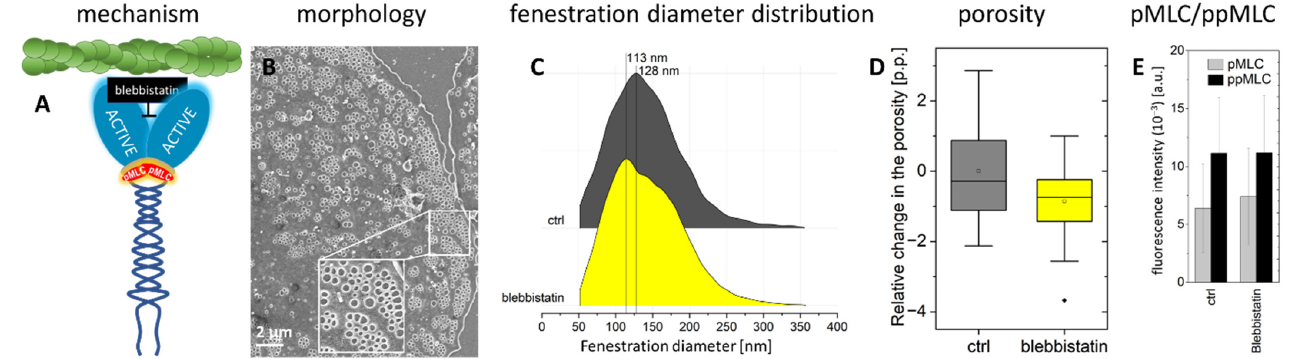
Figure 5. The effect of myosin heavy chain inhibition by 20 µM blebbistatin. ( A ) Schematic presentation of the blebbistatin effect—myosin cannot exert a force on actin, as the myosin motor domain is blocked. The use of blebbistatin uncouples the dependence of pMLC activation on actomyosin contraction. ( B ) Representative SEM image of LSEC treated with 20 µM blebbistatin. ( C ) Fenestration diameter distribution (number of fenestrations measured: ctrl-5402, 20 µM blebbistatin-26017). The proportion of fenestrations > 200 nm is 12% (ctrl) and 13% (20 µM blebbistatin). ( D ) A change in porosity relative to the control is presented ( n = 2). ( E ) A fluorescence signal for pMLC and ppMLC measured using SIM for individual well-spread (fenestrated) LSEC.